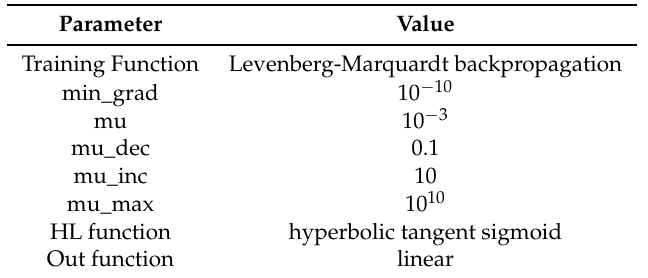
Table 7. Parameter of the ANN